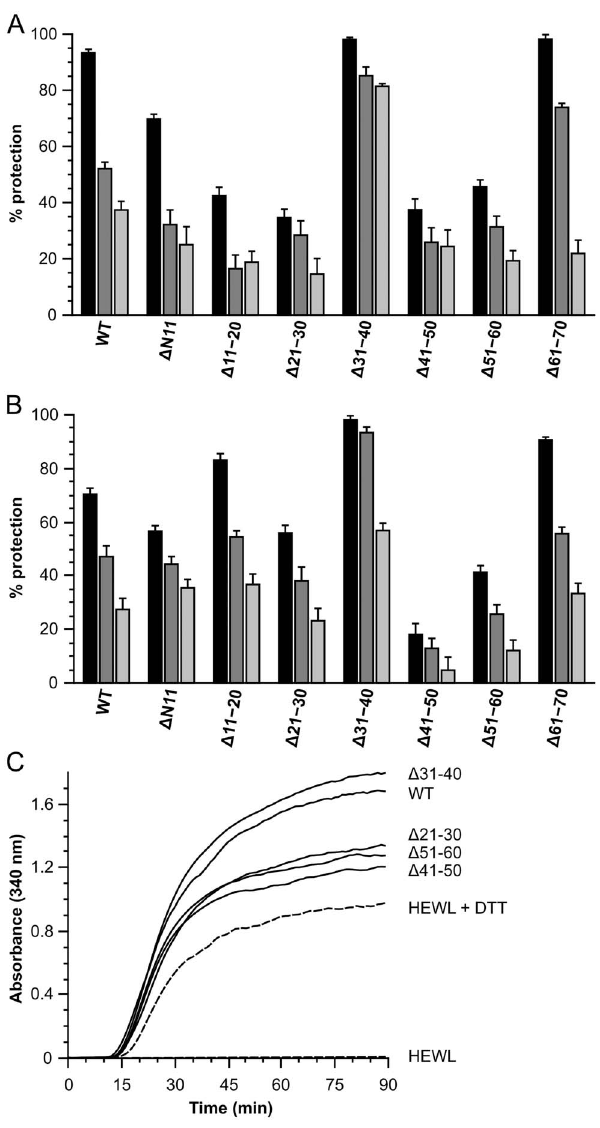
Figure 6. Chaperone-like activity of HSPB6 and the 10-residue deletion mutants. Aggregation was monitored by following the absorbance at 340 nm for 90 min. The percentage protection for each construct was calculated as described in the Materials and Methods. (A) 0.25 mg/ml insulin used as a substrate. Aggregation was induced by adding a final concentration of 10 mM DTT prior to continuous measurement at 37 u C. The ratios of substrate to sHSP are 1:0.2 (black), 1:0.1 (gray) and 1:0.05 (light gray) (B) 0.25 mg/ml yADH used as a substrate. Aggregation was induced by adding 20 mM DTT and 2 mM EDTA (final concentration) prior to measurement at 42 u C. The monomer mass molar ratios of substrate to sHSP were 1:2 (black), 1:1 (gray) and 1:0.5 (light gray). (C) DTT-induced aggregation of HEWL in absence and presence of HSPB6 and the truncations. For clarity not all constructs are shown. The monomer mass molar ratio of HEWL:sHSP was 1:2.